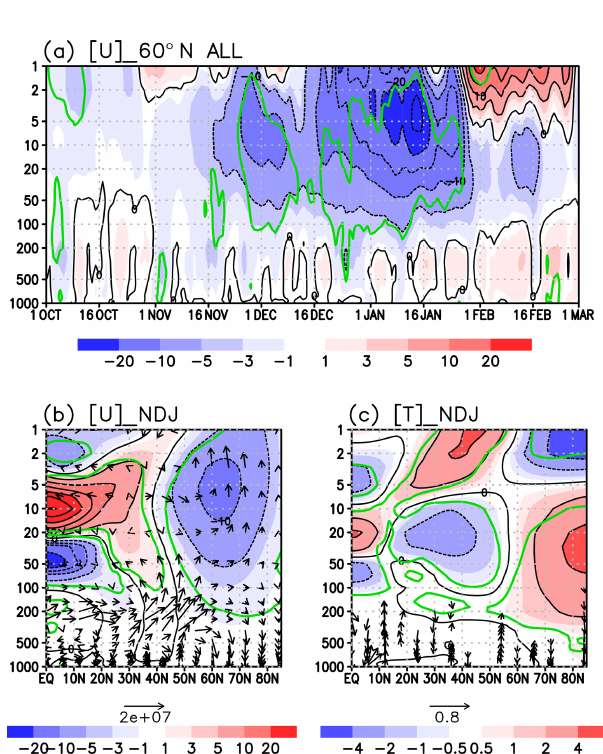
Figure 1. (a) Time–height (pressure) section of the composite dif- ference in zonal-mean zonal wind at 60 ◦ N between EQBO and WQBO winters. Contour interval is 5ms − 1 . Green line denotes the statistically significant value at 95% confidence. (b) Latitude– height section of the composite difference in the zonal-mean zonal wind for the 3-month (November, December and January) mean. Contour interval is 5ms − 1 . The arrows are composite difference in EP flux divided by square root of air density. The unit of EP flux is kgs − 2 and the scale arrow is shown at the bottom. Vertical compo- nent of EP flux is multiplied by 200. (c) The same as panel (b) but for the zonal-mean temperature. Arrows are composite difference in zonal-mean meridional wind (ms − 1 ) and reversed zonal-mean ver- tical p velocity ( ω ;hPas − 1 ). The p velocity is multiplied by 200. Values of (cid:49) | ω | less than 5 . 0 × 10 − 4 Pas − 1 are omitted.